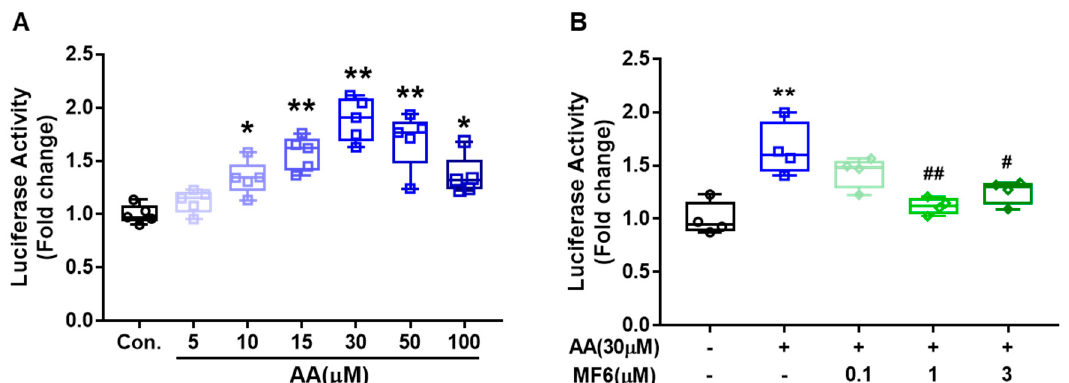
Figure 7. Effects of MF6 administration on AA-induced FABP5 transcriptional activity in SH-SY5Y cells. SH-SY5Y cells were co-transfected with FABP5-pGL3 and Renilla luciferase reporter vectors for 6h. ( A ) After transfection, cells were stimulated with different doses of AA (5 µ M, 10 µ M, 15 µ M, 30 µ M, 50 µ M or 100 µ M) for 24 h (n = 5 per group). ( B ) After transfection, cells were treated with AA/BSA and MF6 (0.1 µ M, 1 µ M or 3 µ M) at the same time for 24 h (n = 4 per group). Promoter activity were represented as firefly/ Renilla luciferase activity and were normalized to control cells (without AA treatment). * p < 0.05, ** p < 0.01 vs. the BSA-treated cells (Con.); # p < 0.05, ## p < 0.01 vs. the AA and vehicle-treated cells. Differences were statistically analyzed using Student's t-test or one-way analysis of variance (ANOVA) followed by Dunnett’s test.